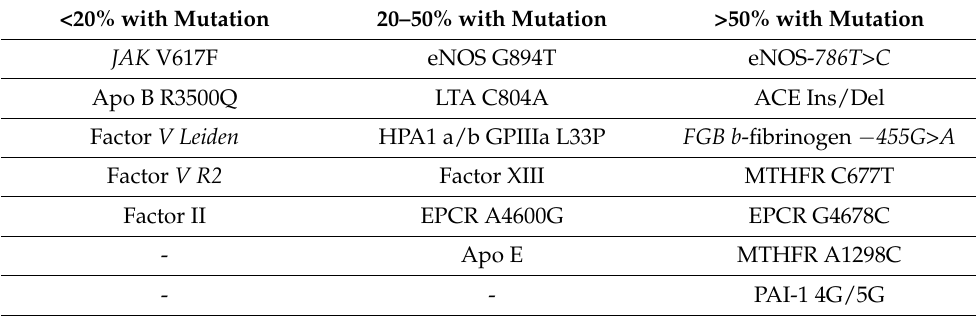
Table 1. Percentage evaluation of results in the table.